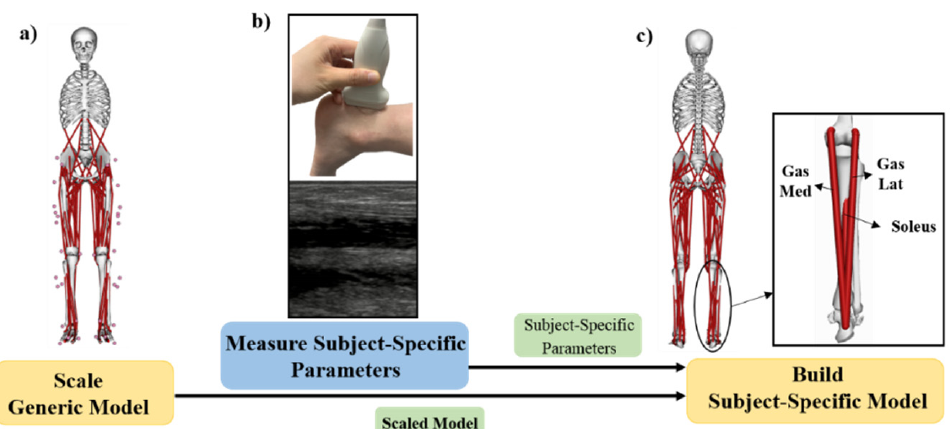
Figure 2. Schematic depiction of the subject-specific musculoskeletal modeling used in this study. ( a ) The generic musculoskeletal model is scaled for each subject using experimental markers placed on anatomical landmarks. ( b ) The slack Achilles tendon length of the involved side was measured with an ultrasound of each subject to obtain subject-specific parameters. ( c ) Graphic depiction of modifying gas_med, gas_lat and soleus muscle-tendon parameters. Note. Gas Med: gastrocnemius medialis, Gas Lat: gastrocnemius lateralis.